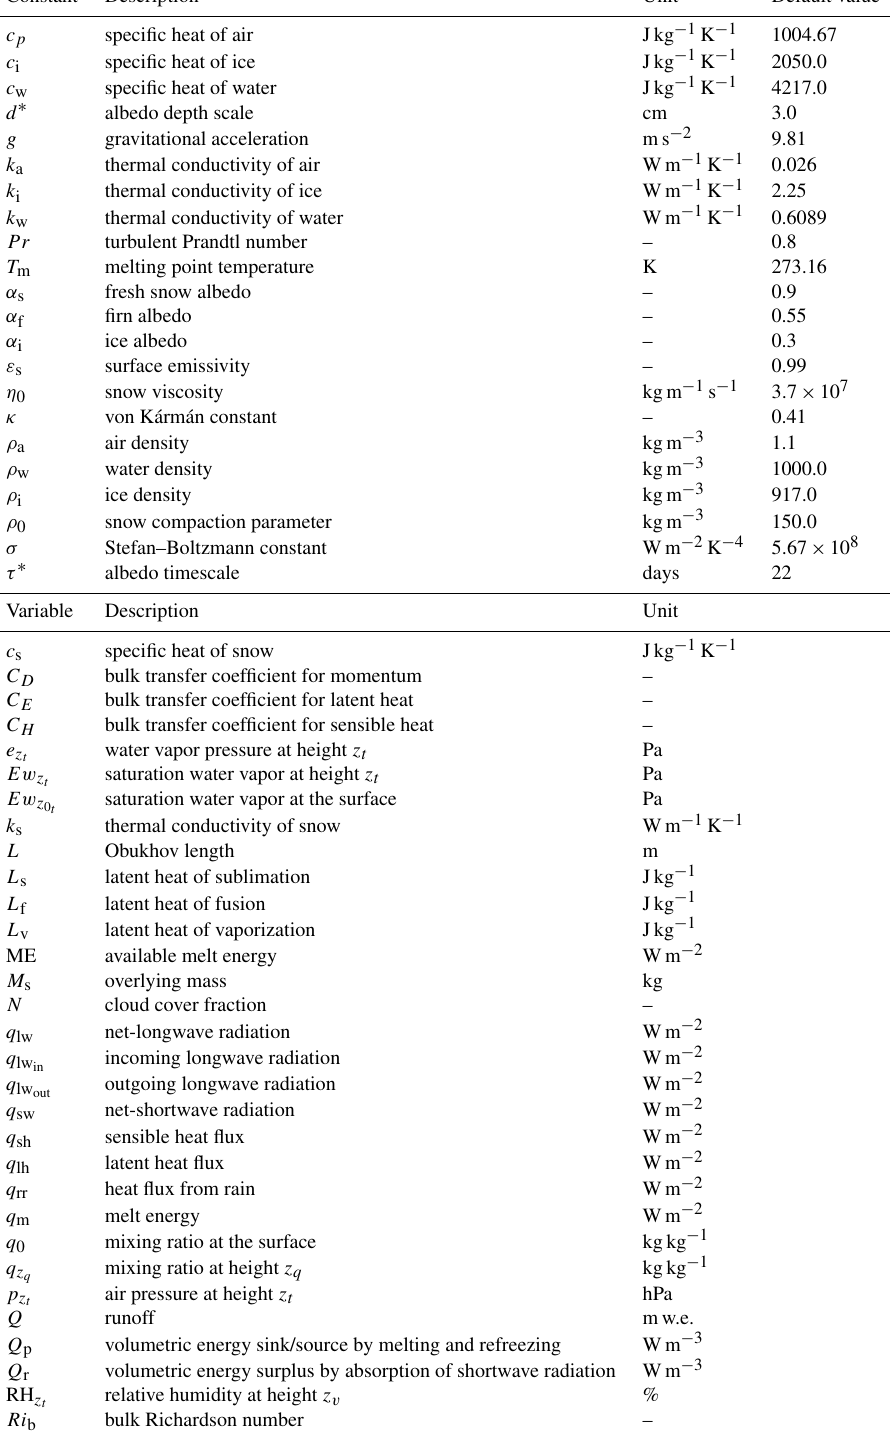
Table A1. List of